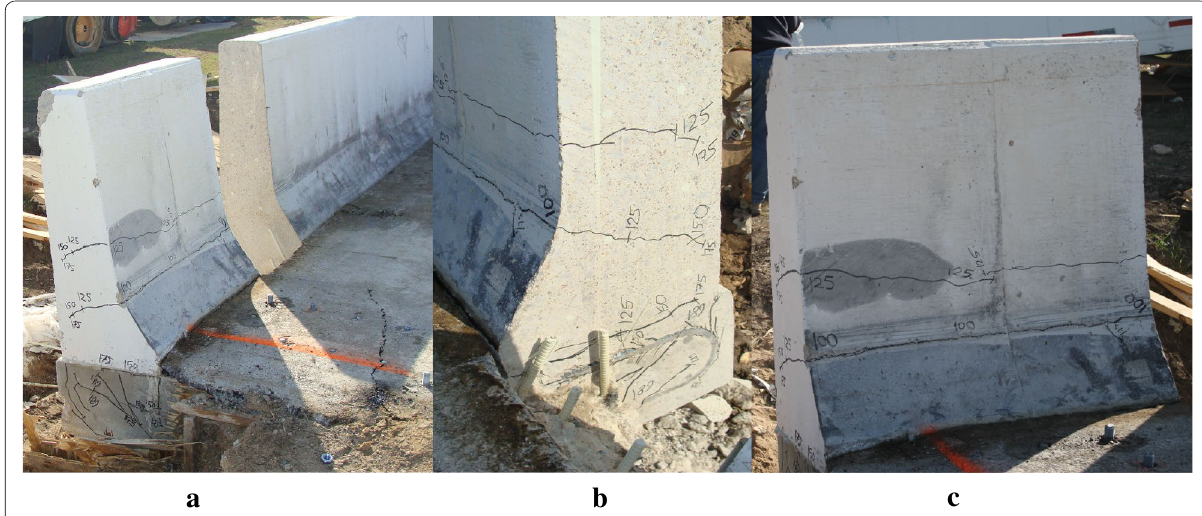
Fig. 18 Crack pattern in the 1000 mm length barrier wall at exterior location. a Left side, b right side, c front